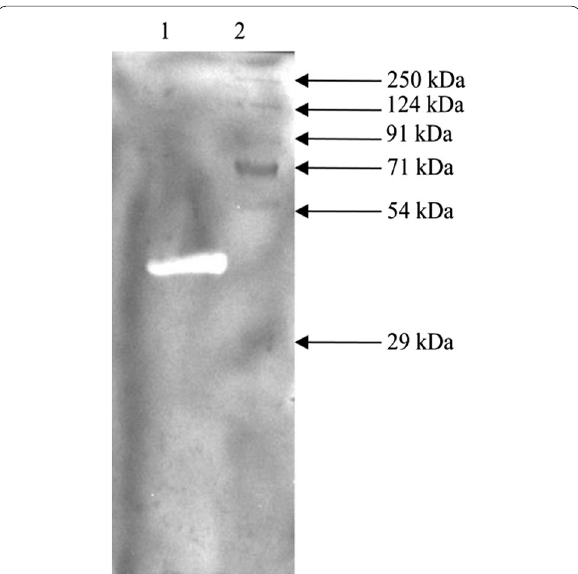
Fig. 4 Western blotting analysis for confirmation of expressed allatotropin . Lane 1—Recombinant protein, Lane 2—Pre-stained marker